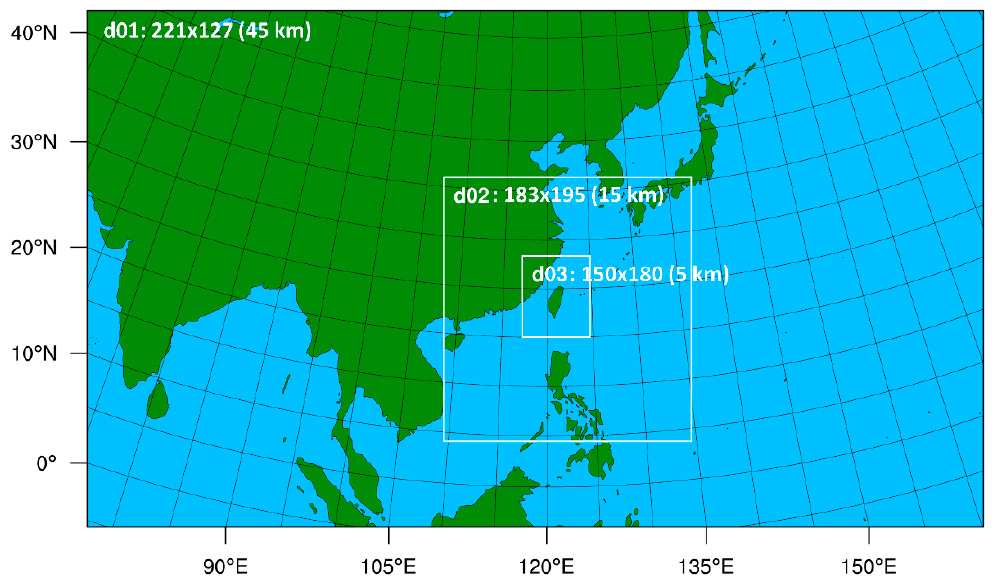
Figure 4. The employed triple-nested WRF model domains.